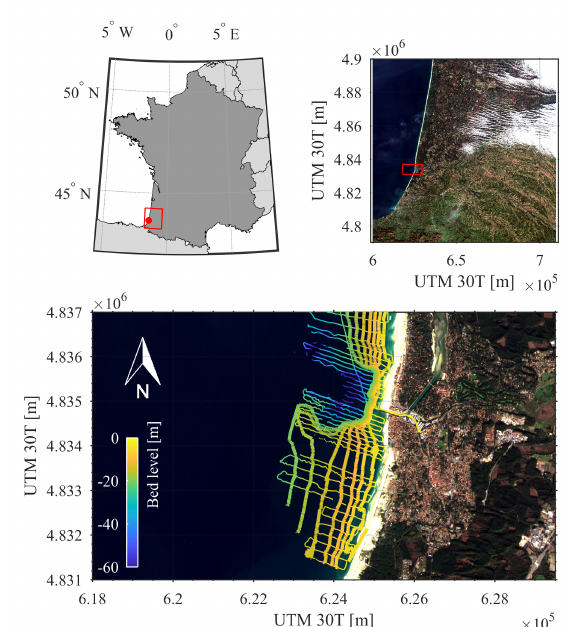
Figure 4. Location of Capbreton in South–West France. The top-left overview shows part of Western Europe in which France is highlighted as the darker grey area (coordinate system WGS84). The red dot represents Capbreton and the box around the dot represents Sentinel-2 tile 30TXP projected on the UTM-zone 30T (Universal Transverse Mercator) . The tiled Sentinel-2 image is presented at the top-right (image taken on 20 November 2017). The red box in the top-right figure highlights the zoomed-in area of the bottom plot. The small dots (mainly on cross shore arrays) represent the echo-sounder measured depths. The thicker predominantly alongshore lines represent the depth isocontours. The deep-water canyon (dark blue dots) is evident close to shore, West–Northwest of the harbour entrance. The echo-sounder was realistically capable of measuring from the shallowest as the boat would go until 60–70 m water